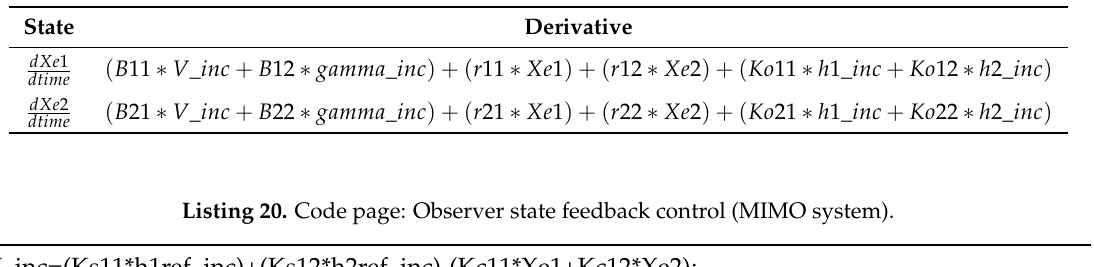
Table 8. ODE page of discrete observer state feedback control (MIMO